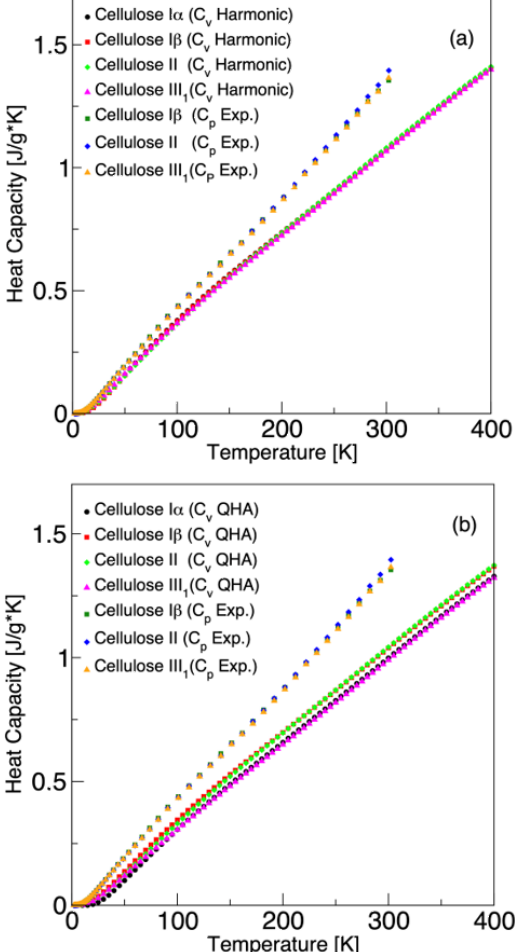
Figure 5. Temperature dependence of thermodynamic properties of cellulose allomorphs. ( a ) Specific heat capacity C v obtained with harmonic approximation. ( b ) Specific heat capacity C v obtained from quasi-harmonic approximation. Experimental C p is included for comparison [12].